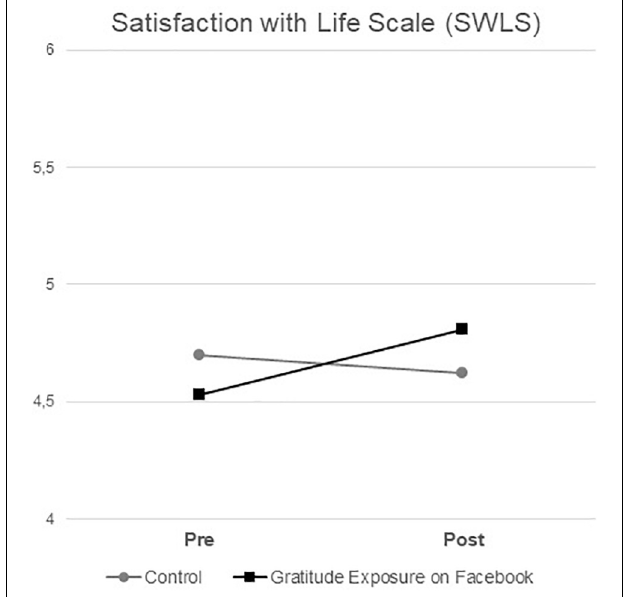
FIGURE 2 | Satisfaction with life scale (SWLS) scores as a function of gratitude exposure on Facebook (control vs. gratitude exposure) and time (pre- vs. post-manipulation). SWLS scores ranged from 1 to 7, with higher scores indicating higher levels of satisfaction with life.